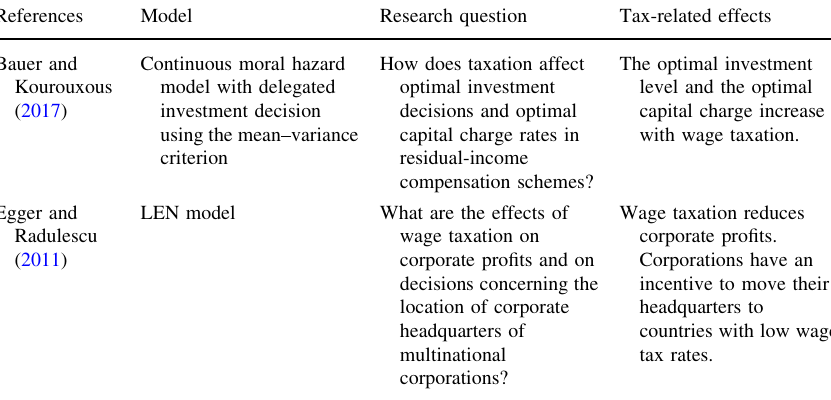
Table 7 summarizes the articles on wage taxation and investment decisions.